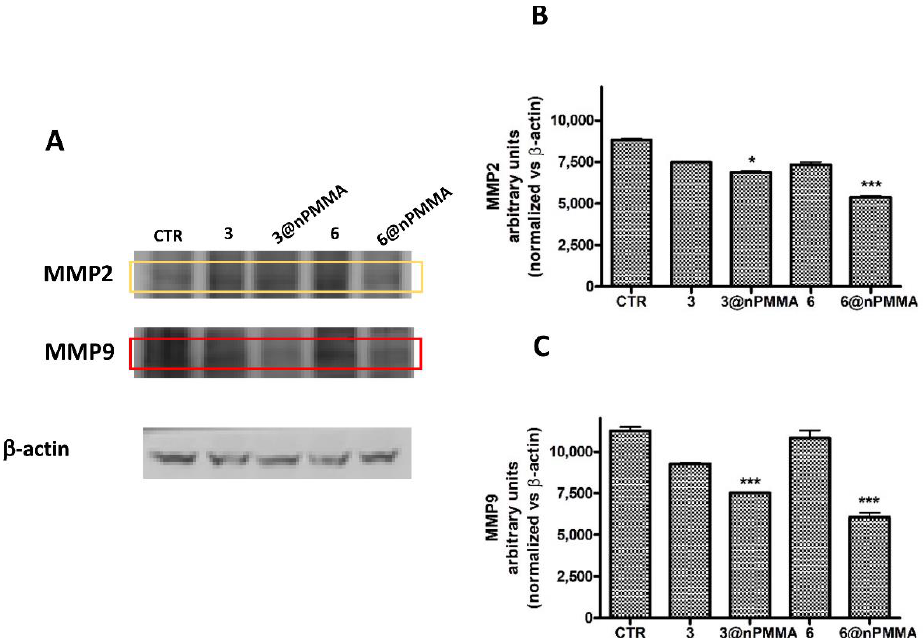
Figure 8. MMP2 and MMP9 protein levels and densitometric analysis in MDA-MB231 cells treated 24 h with subtoxic concentrations (IC 20 ) of 3 , 3@nPMMA , 6 and 6@nPMMA , irradiated for 1 h and incubated for 24 h in a drug free medium at 37 °C. ( A ) Representative western blotting images for MMP2, MMP9 and β -actin protein levels. Densitometric analysis of MMP2 ( B ) and MMP9 ( C ) performed for all the experiments. The results were normalized vs. β -actin protein levels (* p < 0.05, *** p < 0.001 vs. CTR and free BODIPY).